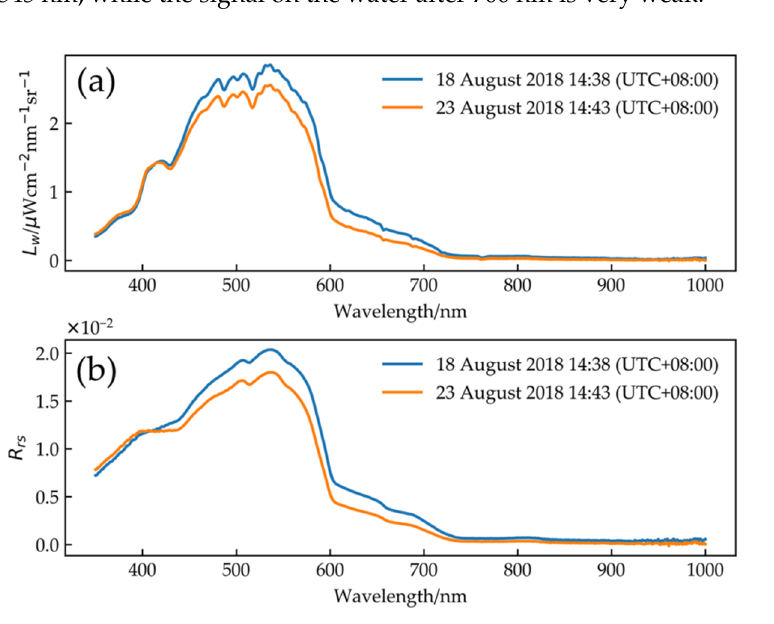
Figure 7. AOD ( a ) at 14:38 (UTC + 08:00), 18 August 2018; ( b ) at 14:43 (UTC + 08:00), 23 August 2018. Whitecap radiance is the radiance produced by foam on the sea surface. According to the assumption that the reflection of the foam is similar to the Lambert reflection, the angle of the sun has little effect, and the whitecap radiance is almost ubiquitous in the satel- lite image. Gordon’s results show that whitecap radiance is independent of wavelength [34], 0- 52 07 3. 6.49 10 s( ) co ( ) / wc s L w F λ θ π= × (11) where 0 θ is the solar zenith angle and